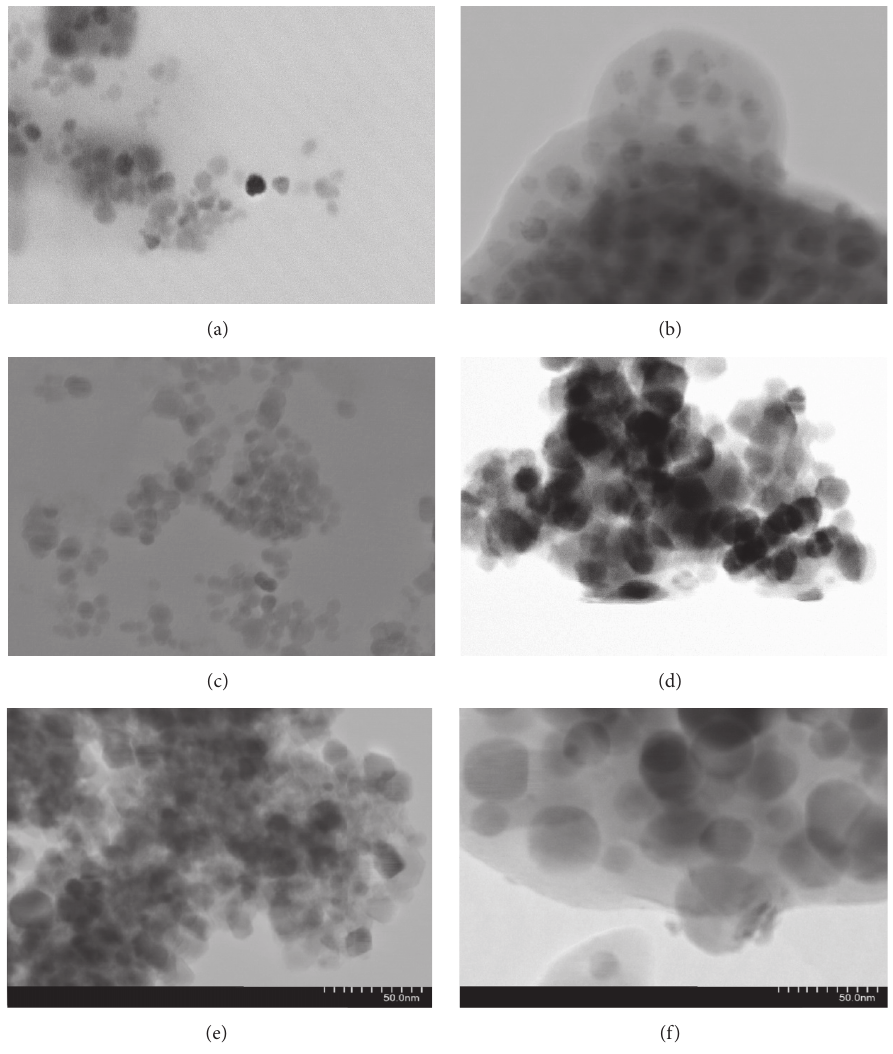
Figure 9: TEM images of gels obtained using 1,2-ED, 1,3-PD, and 1,4-BD, annealed at 700 and 900 ∘